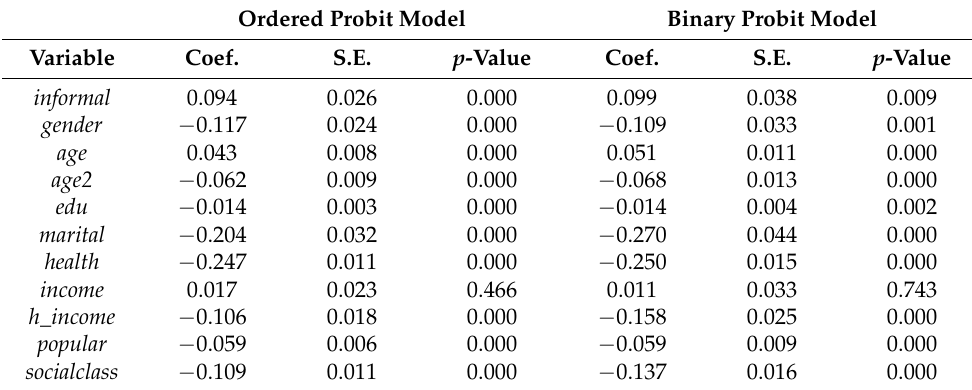
Table 3. Regression results of probit